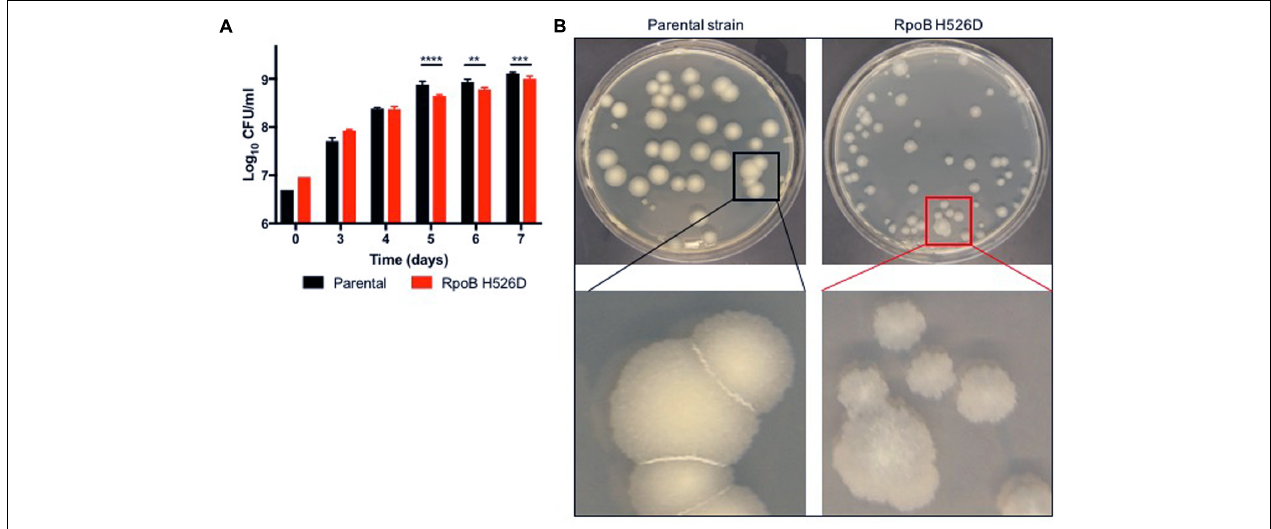
FIGURE 1 | The Mycobacterium tuberculosis (Mtb) RpoB H526D mutant strain exhibits slow growth rate and altered colony morphology. (A) Growth kinetics of Mtb strains in supplemented Middlebrook 7H9 broth. ∗∗ p < 0.01, ∗∗∗ p < 0.001, ∗∗∗∗ p < 0.0001. (B) Mtb cultures were grown on Middlebrook 7H10 agar and colonies were photographed 32 days post-inoculation. Colonies of the RpoB H526D mutant are smaller, more translucent, and less regular than those of the parental strain.